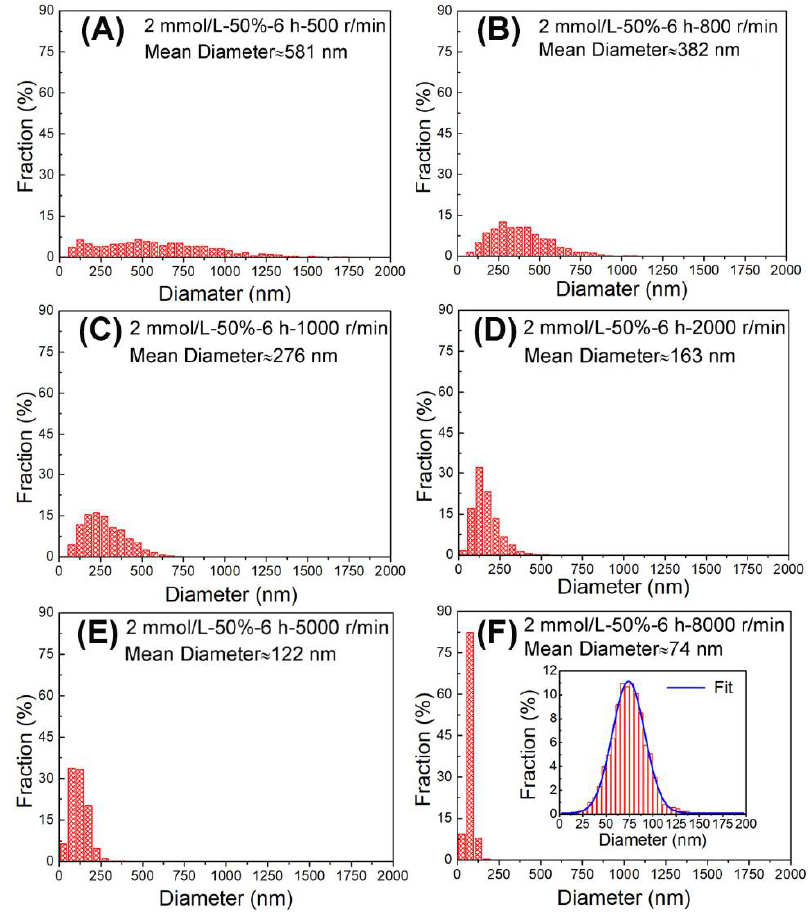
Figure 8. Size distributions of eGaIn nanodroplets under different centrifugal speeds: ( A ) 500 r/min, ( B ) 800 r/min, ( C ) 1000 r/min, ( D ) 2000 r/min, ( E ) 5000 r/min, and ( F ) 8000 r/min.